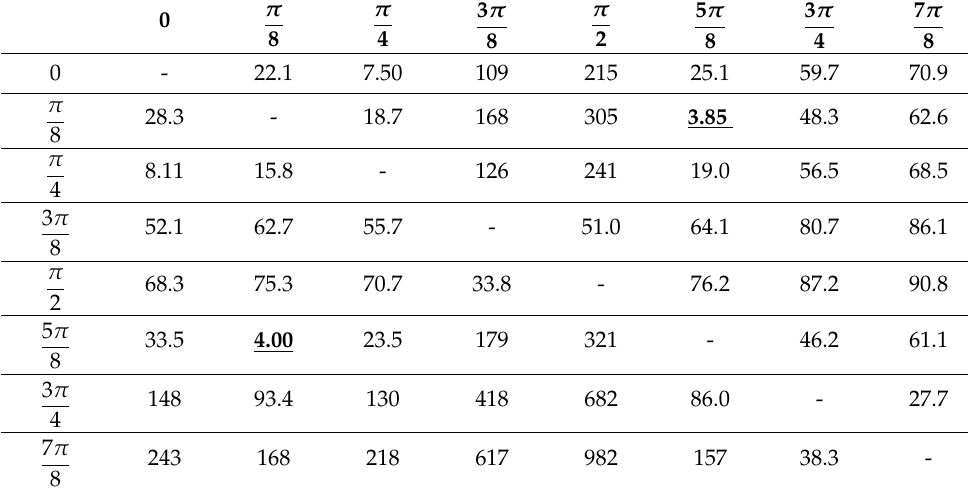
Table 8. Percent error at peak magnification between a microlensing photometric curve with Φ shown in the first row, compared to the photometric curve with Φ in the first column. Error values for R = 42,000 km. Values in bold underline show where % error between the two curves is less than 10%. π 0